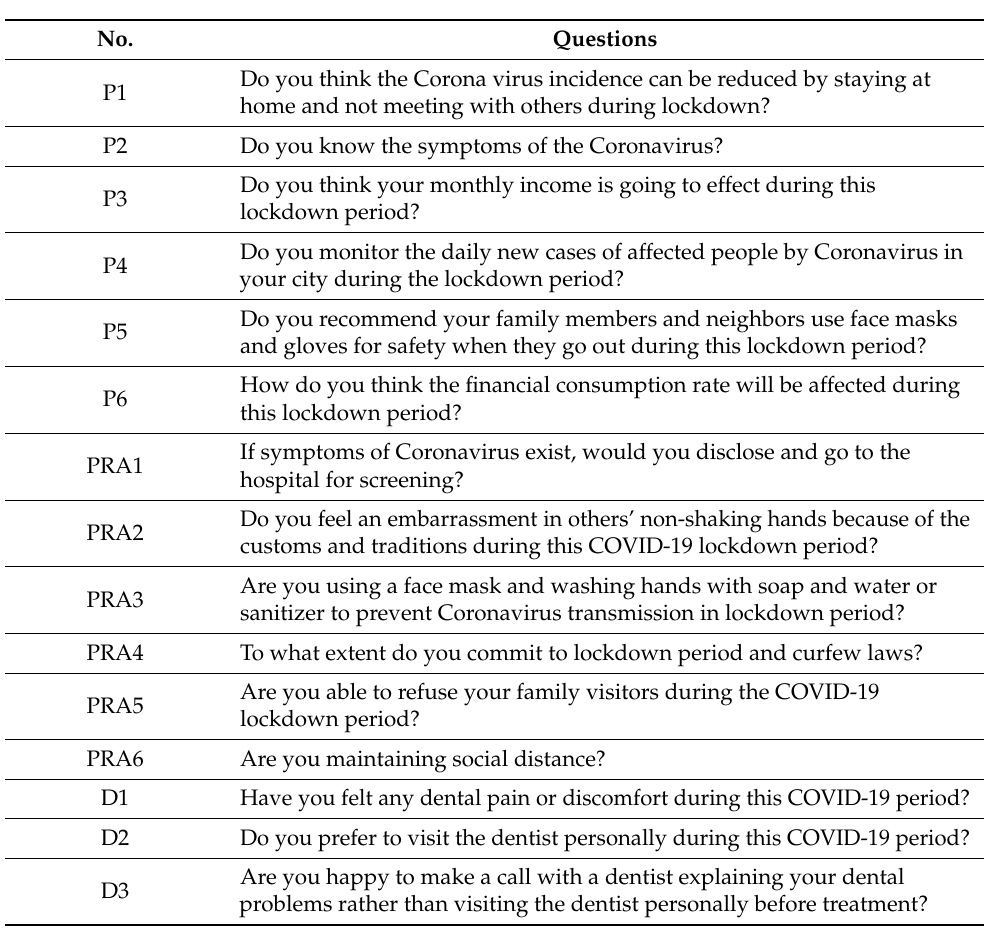
Table 1. Questions related to perception (P), preventive practice (PRA), and oral health care percep- tions